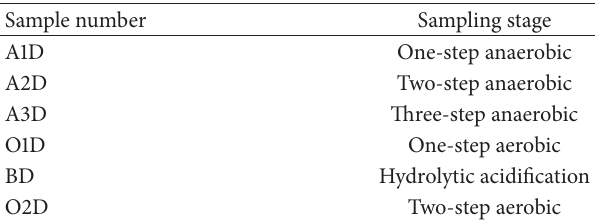
Table 2: Sludge sample number information in the reactor.